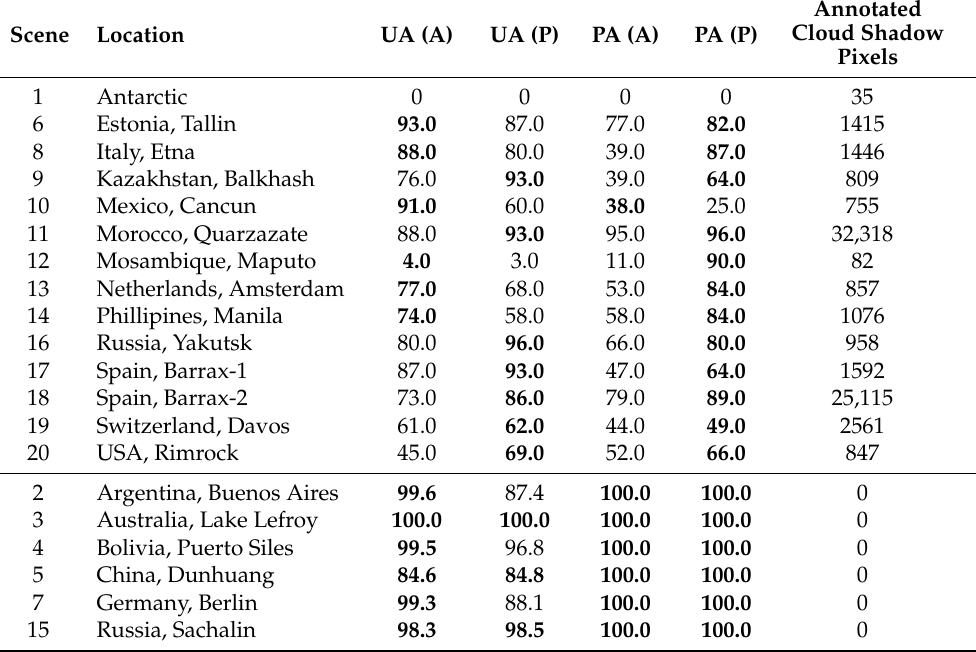
Table 4. Summary of cloud shadow class user and producer accuracies (percent) (A = ATCOR, P = PACO; bold face numbers indicate the best